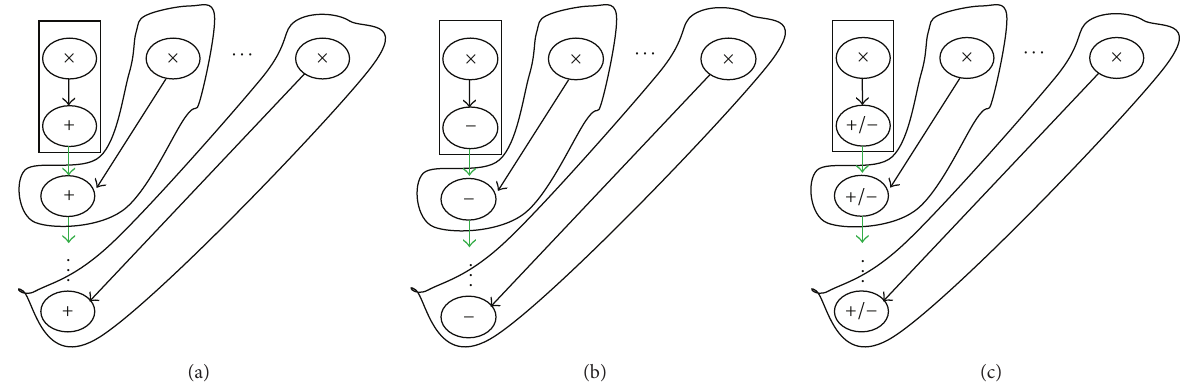
Figure 5: Mapping of operations in a chain of allied operations to DSP blocks.